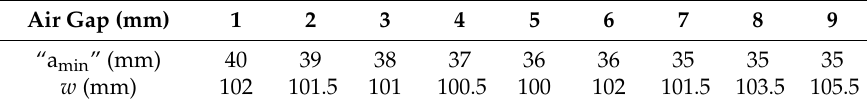
Figure 5. Calculation results: η vs. parameter “ a ” for different air gap width w air . Table 1. Minimum coil size satisfying η < 10 for different air gap width.